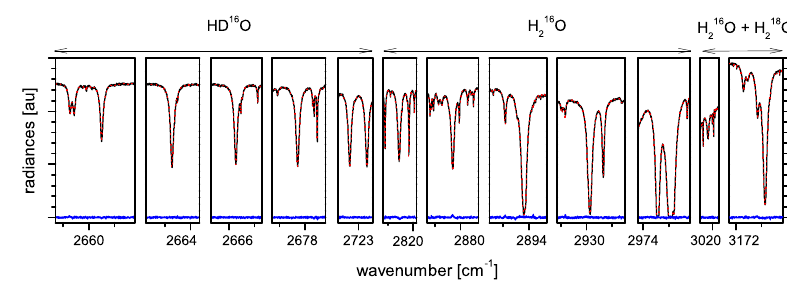
Fig. 2. Same as Fig. 1 but for the 1090 - 1330 cm − 1 retrieval.